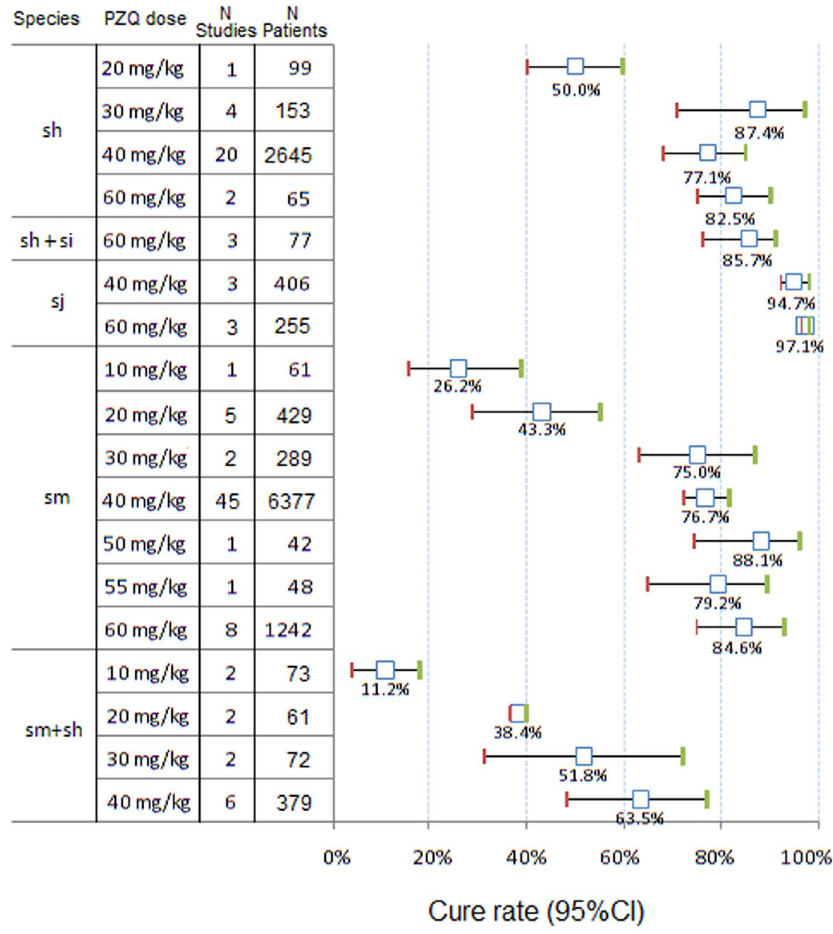
Figure 2. Forest plot of praziquantel (PZQ) cure rates with 95% CIs by species and dose (all age groups). sh, S. haematobium ; si, S. intercalatum ; sj, S. japonicum ; sm, S. mansoni .